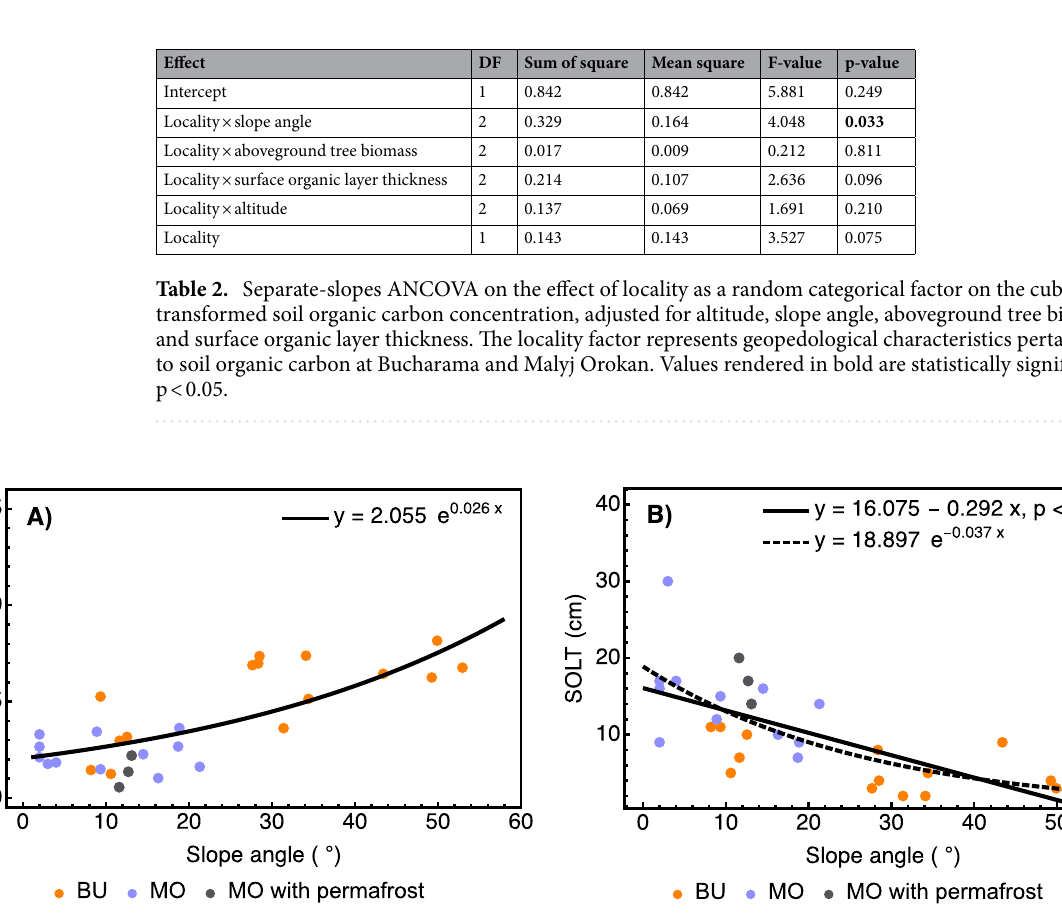
Figure 2. ( A ) The relationship between soil organic carbon concentration (SOCC) and slope angle is fitted by the exponential function. RMSE = 1.528; AIC = 107.523. ( B ) Relationship between surface organic layer thickness (SOLT) and slope angle. Linear fit: adj. R 2 = 0.445; RMSE = 4.792; AIC = 183.152.